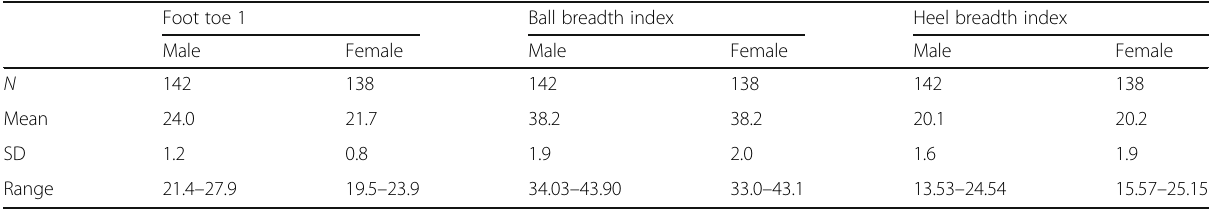
Table 2 Descriptive statistics: left foot dimensions and foot index among Punjabi